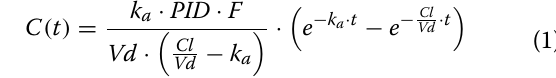
where E 0 is the baseline blood lactate level and k, the rate constant of the effect. The model was applied to VPA-attributed effects using the maximum likelihood expectation maximization algorithm implemented in WinNonlin ® version 8.02 (Pharsight Corp., Mountain View, CA). All model parameters were assumed log- normally distributed. The model selection was based on goodness-of-fit criteria, which included the convergence criterion, the Akaike information criterion, the estima- tion criterion value for the maximum likelihood method, and the visual inspection of predicted versus observed and residual plots. Parameters of the concentration-effect relationships are expressed as mean (coefficient of varia- tion) of individual